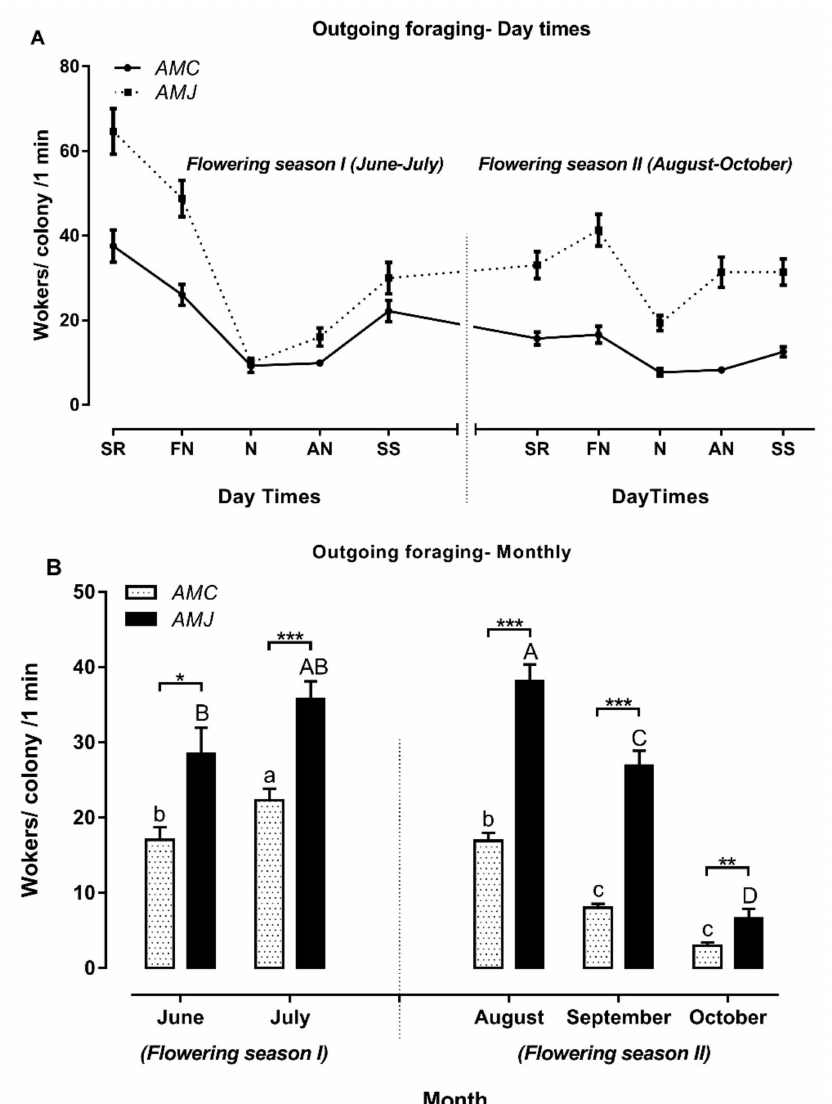
Figure 4. Outgoing foraging activities of two honey bee subspecies during the two flowering seasons of Z. nummularia in central Arabia. ( A ) Outgoing foraging activities (mean ± SEM) of AMJ and AMC recorded at different times of day (SR: sunrise, FN: forenoon, N: noon, AN: afternoon, and SS: sunset). ( B ) Monthly values (mean ± SEM) of the outgoing foraging activities of AMJ and AMC during the two flowering seasons (season I and season II). SEM: standard error of the mean. Flowering season I lasted from June–July, and flowering season II lasted from August–October. Different letters indicate significant differences among the foraging activities within each subspecies given in different columns at p < 0.05. The asterisks indicate significant differences between the foraging activities of the two subspecies in a single month (* p < 0.05; ** p < 0.01; *** p <